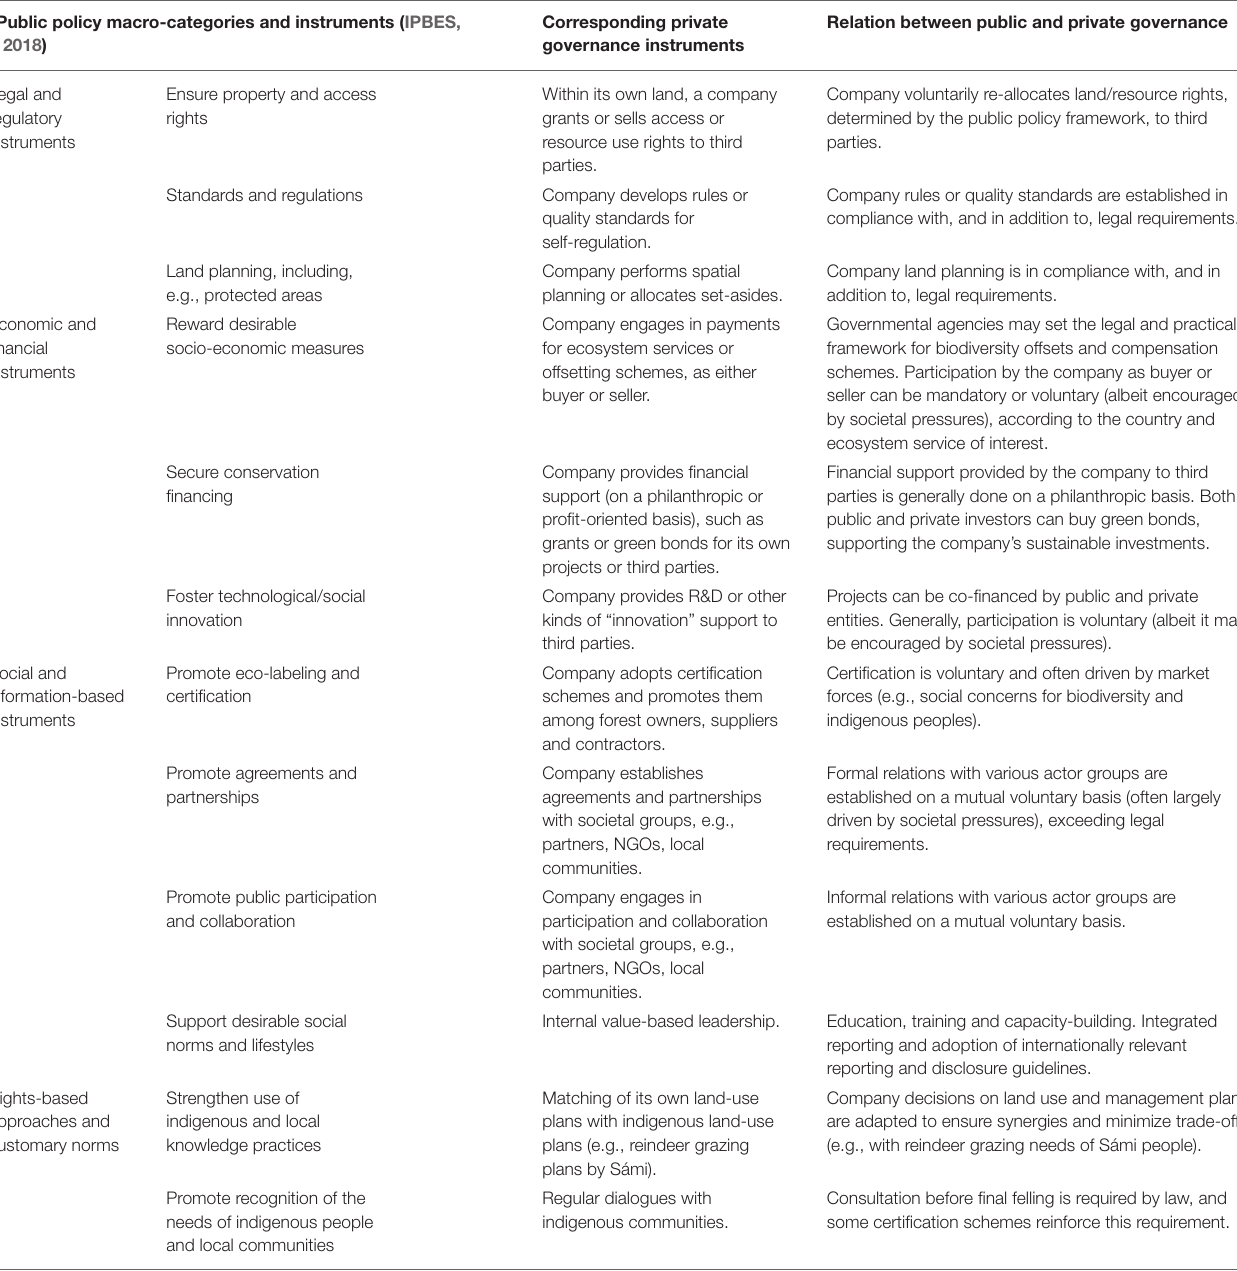
TABLE 1 | Public policy instruments translated into instruments for private governance of BES (own elaboration, adapted from IPBES, 2018). Public policy macro-categories and instruments (IPBES,